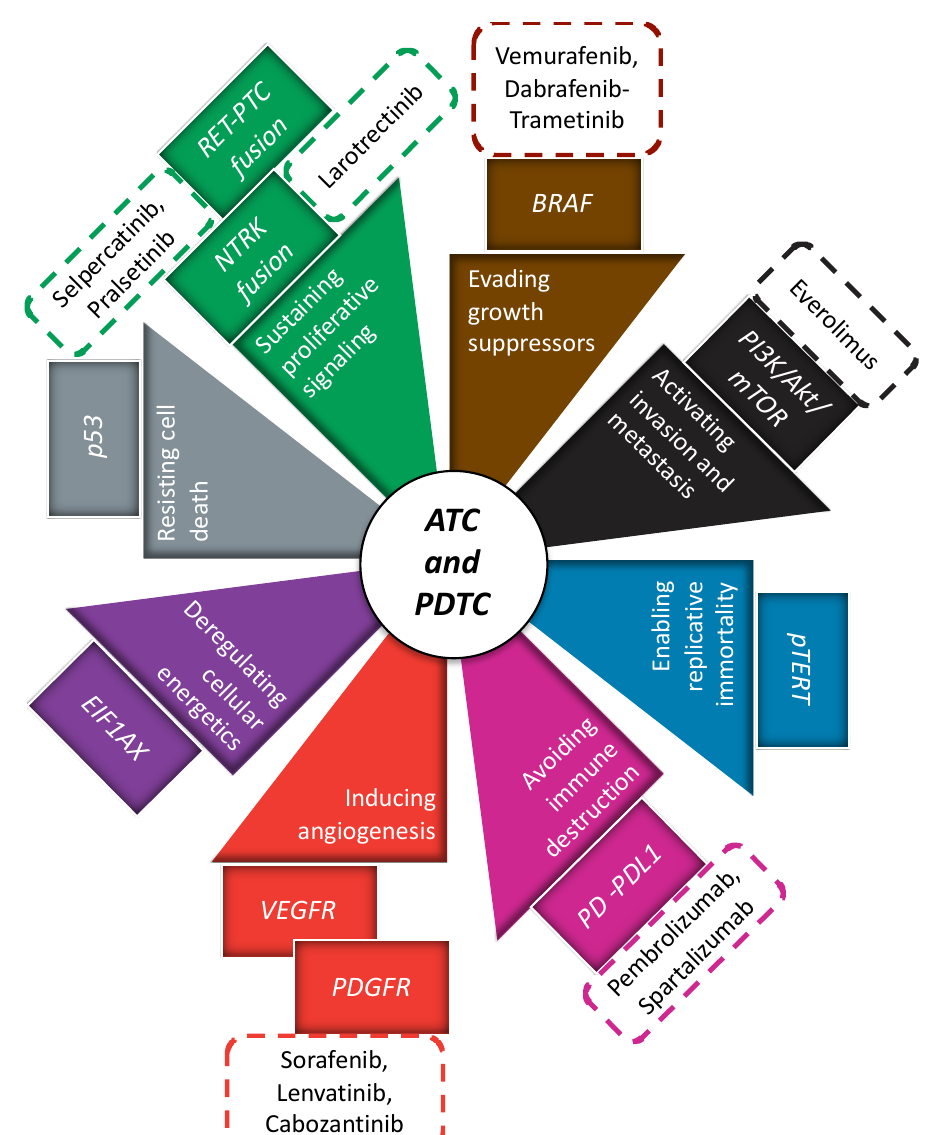
Figure 3. All innovative therapies that have been suggested in ATC and PDTC (rectangular box with dotted lines); each of them has been related to a specific inhibition of hallmark of cancer (triangle box) and cellular pathway (rectangular box)